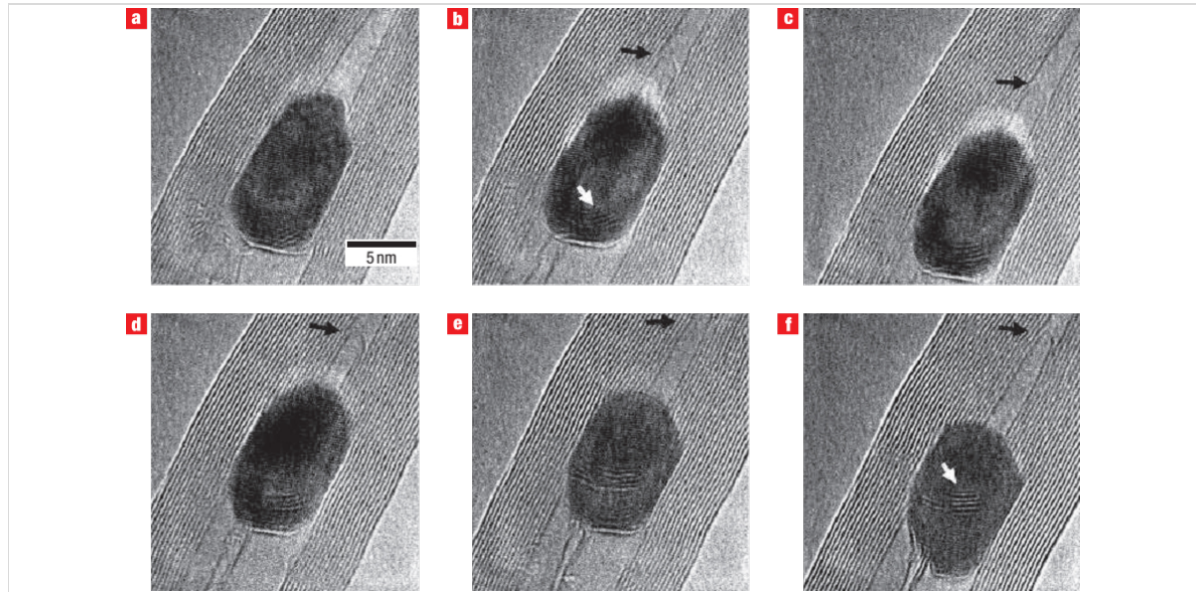
Figure 7: SWCNT growth from Fe with possible occurrence of a carbide phase. The HRTEM images show the growth of a SWCNT inside a MWCNT, which is partly filled with a Fe crystal under electron irradiation (ca. 200 A/cm 2 ) at a specimen temperature of 600 °C. The tip of the growing SWCNT is indicated by a black arrow. Images taken (a) before the growth, (b) after 5 min, (c) after 6 min, (d) after 7 min, (e) after 13 min, (f) after 15 min of ir- radiation respectively; reproduced with permission from [105], Copyright (2007) Nature Publishing